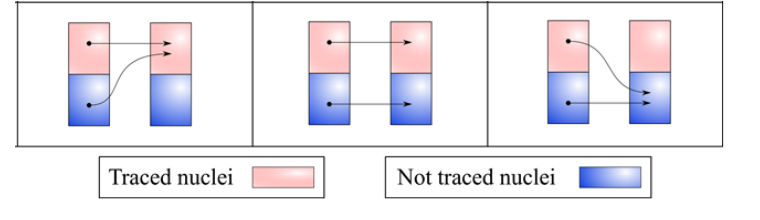
Figure 1. Schematic overview of the nucleosynthesis tracing framework. All nuclei belong to either a traced population (top red boxes) or an untraced population (bottom blue boxes). Every nuclear reaction, decay, and fission channel is cast into one of three types based on how it maps its products into the traced and untraced populations. The first type maps product(s) exclusively to the traced population (left panel). The second type preserves the traced and untraced populations between the reactant(s) and product(s) (center panel). The last type maps product(s) exclusively to the untraced population (right